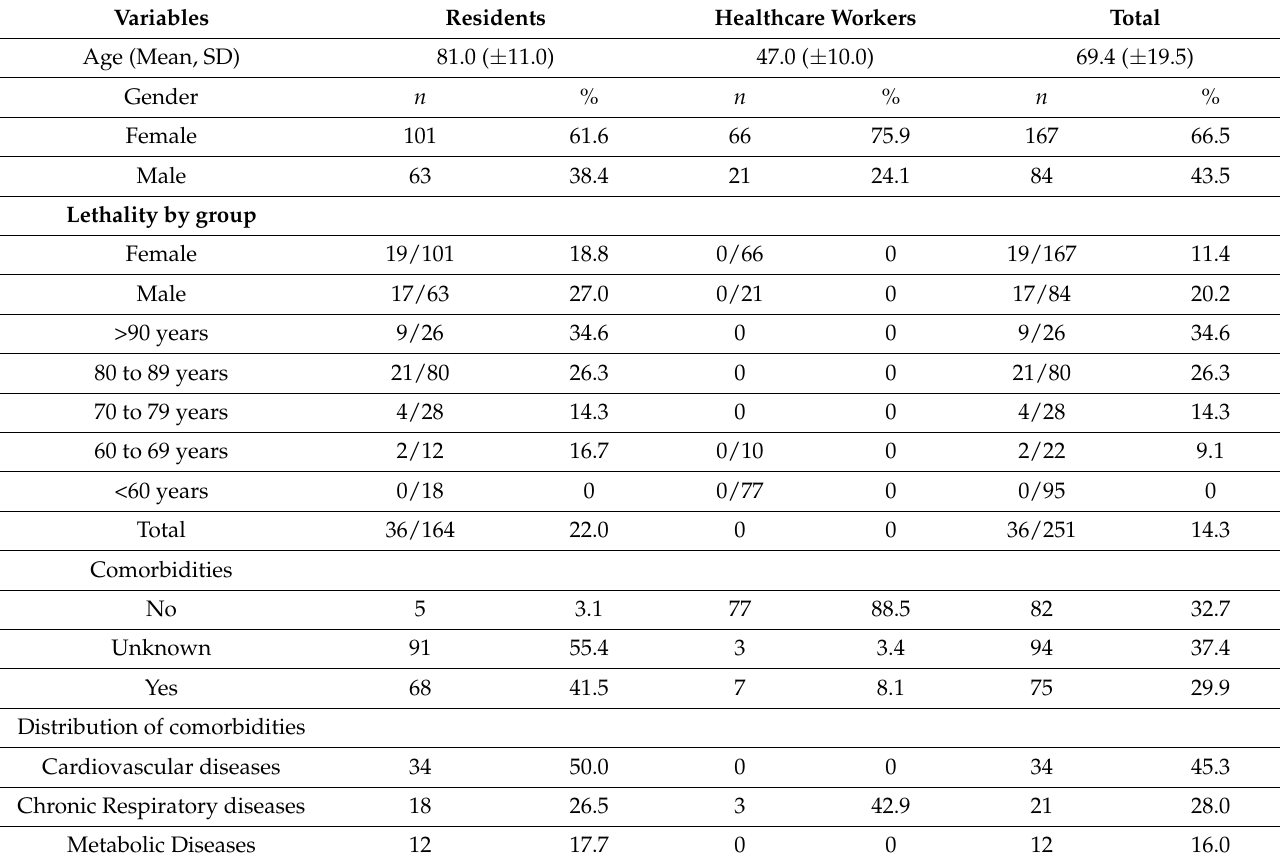
Table 3. Characteristics of SARS-CoV-2 cases among facilities with outbreaks during the first pandemic phase.